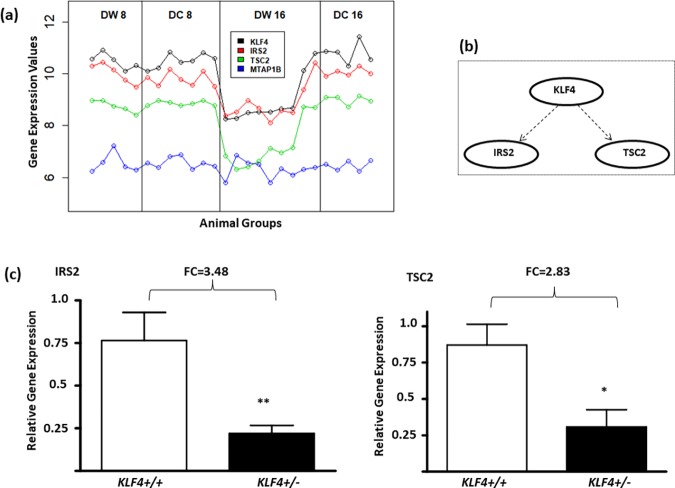
Regulation of IRS2 and TSC2 by KLF4.(a) Strong correlation of expression patterns of KLF4, IRS2 and TSC2 across different conditions (DC8, DW8, DC16, DW16), but little correlation with expression of the negative control gene, MTAP1B, across the different conditions. (b) Since KLF4 is a known transcriptional regulator and KLF4 binding motifs are present in IRS2 and TSC2 gene promoters, we conjectured that KLF4 regulates the expression of the two genes. (c) Relative mRNA expression levels (shown as means +/- SEM) of IRS2 (left panel) and TSC2 (right panel) in adipose tissues of KLF4-deficient (KLF4+/-, N = 4) and KLF4 wild type (KLF4+/+, N = 4) adipose tissues with fold changes (FC) as indicated. * p = 0.06 and ** p <0.05. The relative expression levels of MTAP1B mRNA were not different between KLF4+/- and KLF4+/+ adipose tissues.